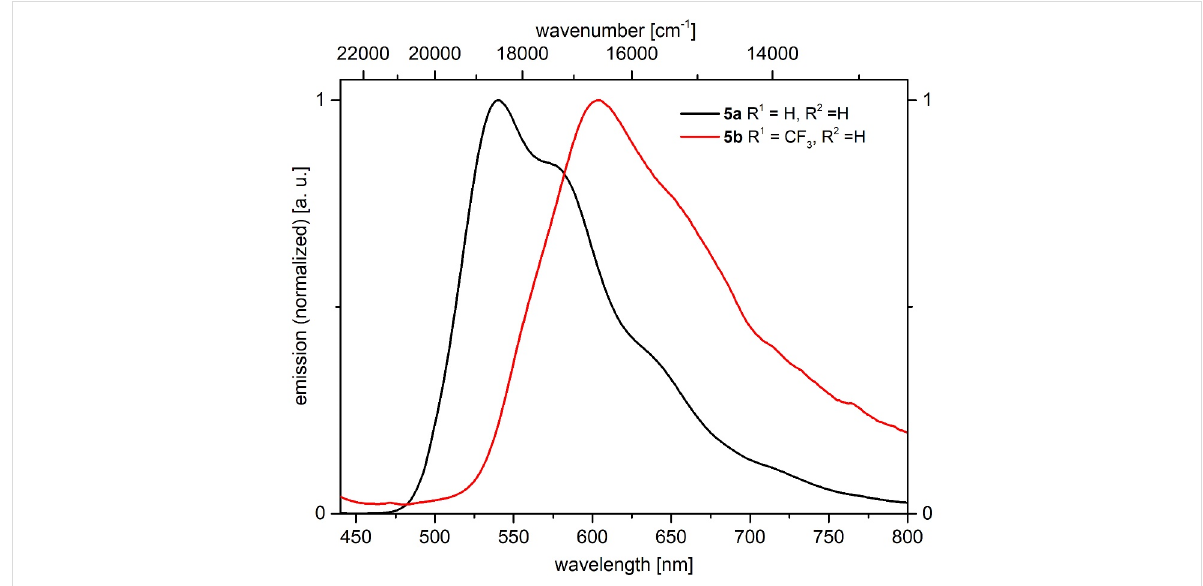
Table 9). While the polarity effect on the absorption